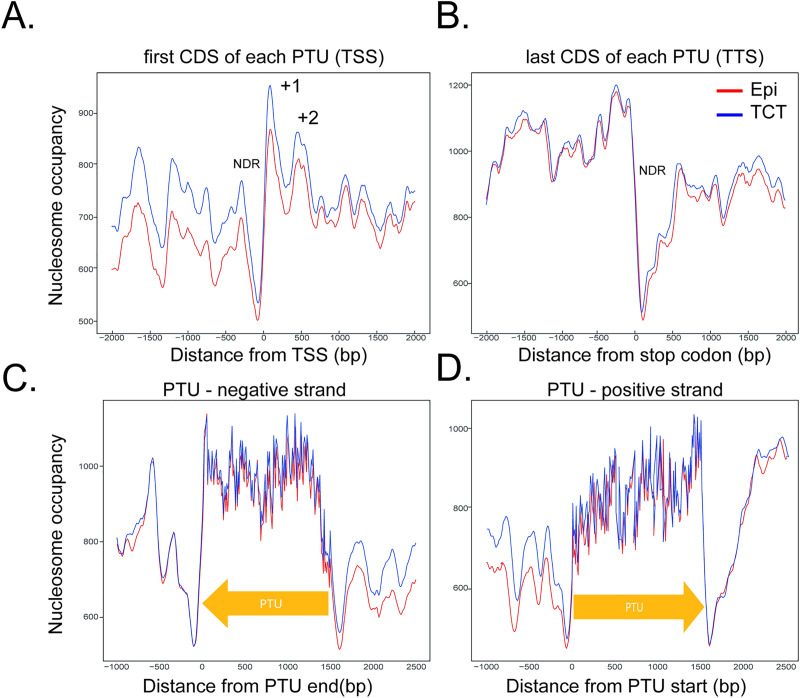
Nucleosome occupancy along PTUs in epimastigotes (red) and TCTs (blue).A. Nucleosome occupancy around the first CDS of each PTU. The nucleosome occupancy at the last CDS of each PTU (B). C. Nucleosome occupancy across negative strand PTUs. D. Nucleosome occupancy across positive strand PTUs. In A and D, the first ATG is represented as 0 on the x axis. In B and C, the last base of each CDS is represented by 0 on the x axis.